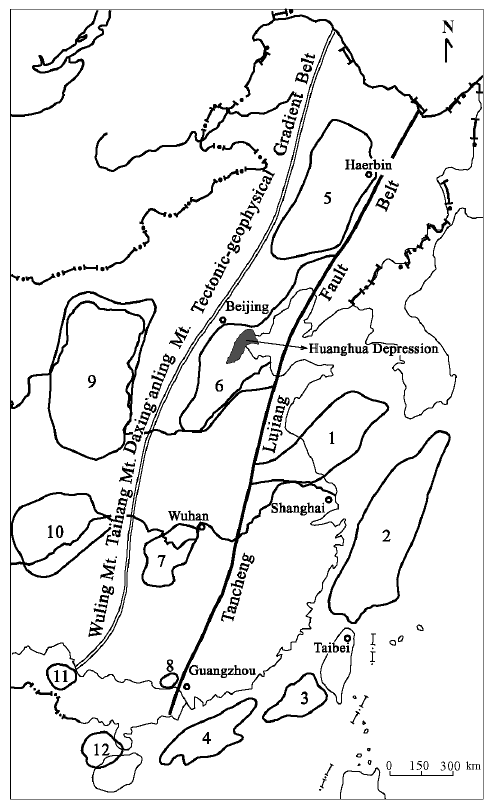
Fig. 1. Tectonic location of the Huanghua Depres- sion in the Huaxia rift system, China (Ishibashi et al. , 2002): 1 – Subei-South Huanghai Basin; 2 – Donghai Basin; 3 – Taixinan Basin; 4 – Zhujiangkou Basin; 5 – Songliao Basin; 6 – Bohaiwan Basin; 7 – Jiang- han Basin; 8 – Sanshui Basin; 9 – Ordos Basin; 10 – Sichuan Basin; 11 – Baise Basin.